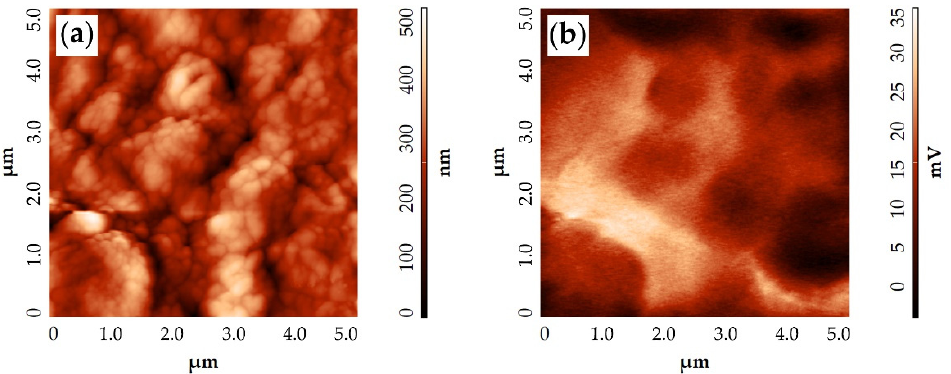
Figure 9. Microstructure of the NiCo 2 O 4 film: ( a )—topography (AFM), ( b )—surface potential distri- bution map (KPFM).